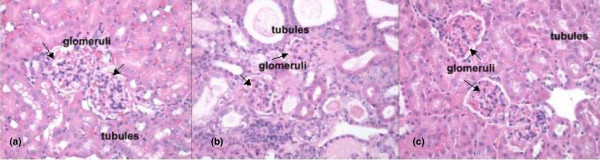
Kidney histology. Representative sections of renal cortex from NZB × NZW F1 female mice. (a) Section of kidney with glomeruli (arrows) and tubules that are within normal limits from a 12-week-old mouse. (b) Section from an untreated 36-week-old mouse. Glomeruli (arrows) are small with markedly thickened basement membranes and decreased numbers of cells (glomerulosclerosis). Tubules are dilated and contain protein casts or droplets in the lumens. (c) Section from a 36-week-old mouse treated with sirolimus has kidneys that are within normal limits. Glomerular (arrows) basement membranes are slightly thicker than those in the untreated 12-week-old mice. H & E, 40× original magnification.